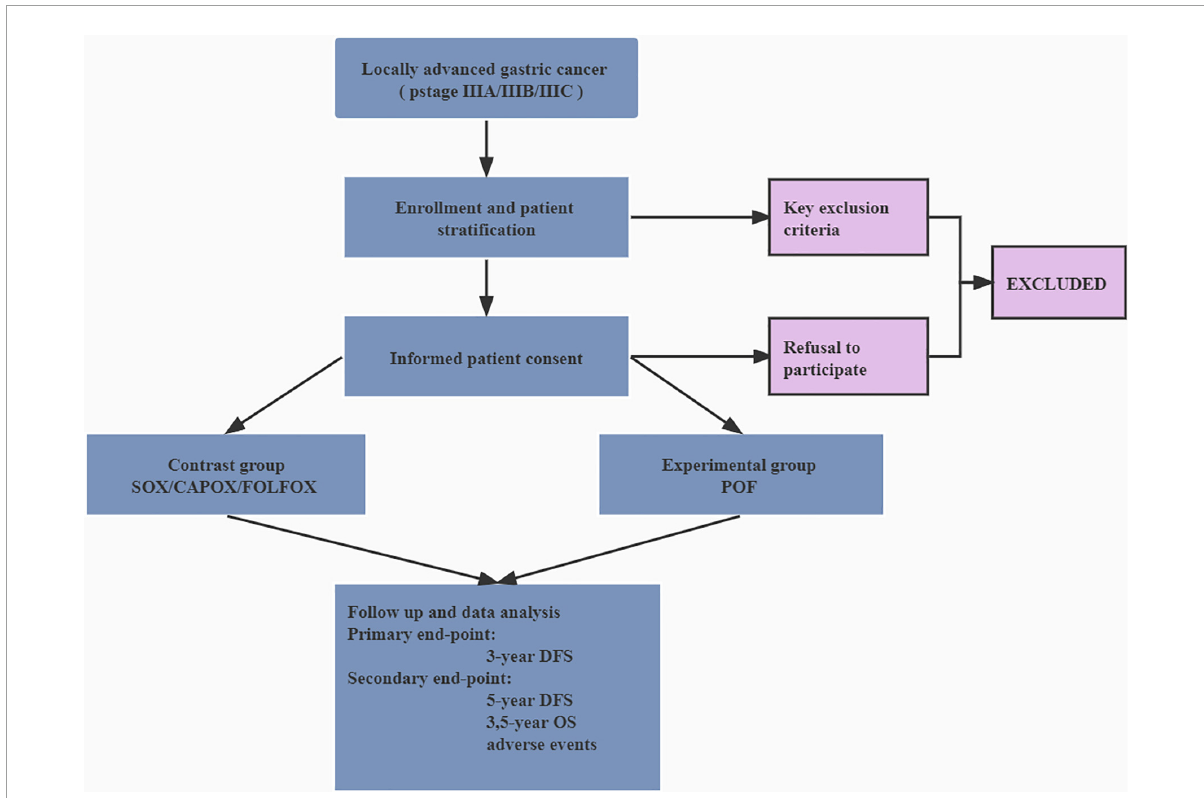
FIGURE1 Flow diagram of the trial. DFS, disease-free survival; OS, overall survival; SOX, oxaliplatin and S-1; CAPOX, oxaliplatin and capecitabine; FOLFOX, folinic acid (or leucovorin), 5-fluorouracil and oxaliplatin; POF, paclitaxel, folinic acid (or leucovorin), 5-fluorouracil, and oxaliplatin.